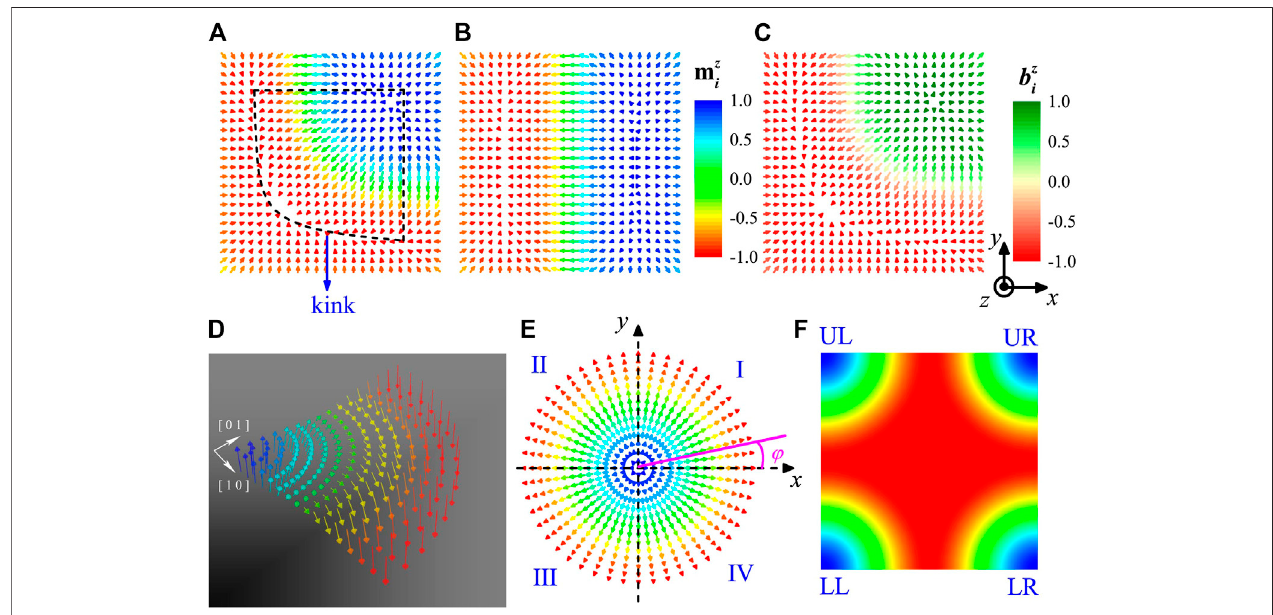
FIGURE2|(A) Themagneticstructureobtainedfromtheabovestatein Figure1B afterwithdrawalofmagnetic fi eld.Akinkstructureisenclosedbythedashlines. (B) A spiral structure, as the possible ground state of nanostructure with a size of 24 × 24 square lattices (i.e., ∼ 12 × 12nm) in the absence of magnetic fi eld . (C) The reduced effective fi eld b i pro fi le corresponding to the magnetic structure in (A) . (D) Schematic illustrations of the kink structure (E) Schematic illustrations of an isolated skyrmion con fi guration, which canbe dividedinto four quadrants along thedash lines, denoted askink I,II, III,and IV. (F) Thesekinks mayappearinone ofthefour possible corners (i.e., LL, LR, UR or UL corner) in the nanostructure, corresponding to kinks residing in the four possible quadrants (i.e., quadrant I, II, III or IV).